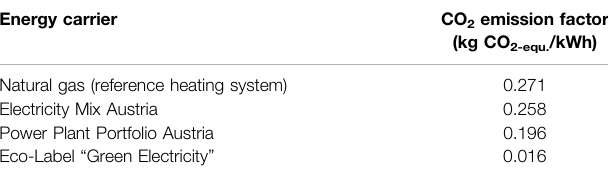
TABLE 4 | CO 2 -emission factors for different energy sources (UBA, 2019).